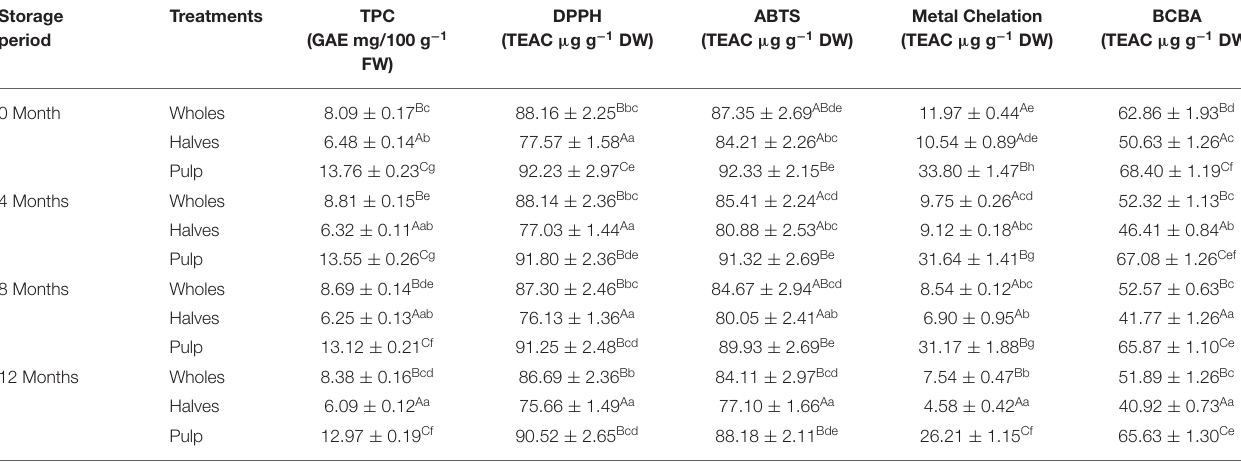
TABLE 4 | Effect of canning and storage on total phenolic content and antioxidant properties of apricot wholes, halves and pulp. Storage